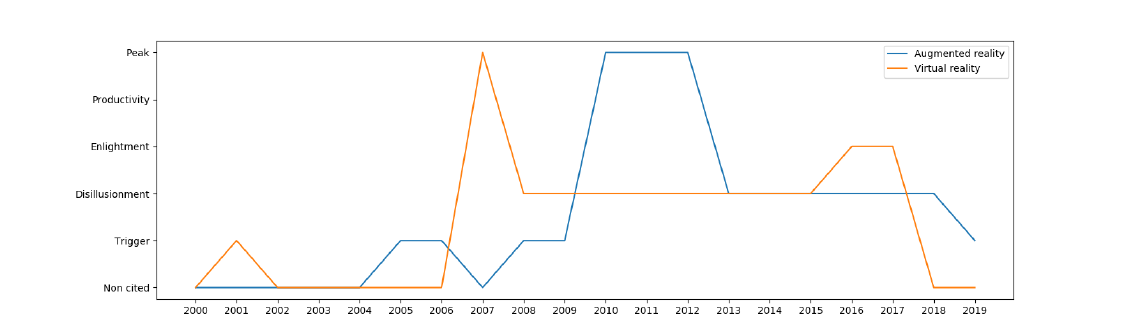
Figure 4. Evolution of augmented reality (AR) and virtual reality (VR) technologies in the hype cycle.